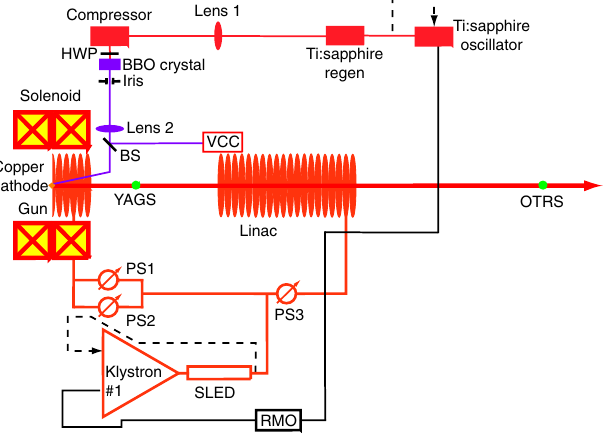
FIG. 1. Experiment schematic of the two-photon emission from a copper cathode of an X -band photoinjector (not to the scale). Lens 1 is the imaging relaying lens, lens 2 images an iris onto the cathode. HWP, half-wave plate; BS, beam splitter; VCC, virtual charge-coupled device camera; PS, phase shifter; RMO, radio master clock; YAGS, yttrium aluminum garnet screen; OTRS, optical transition radiation screen; PS, phase shifter; SLED, SLAC linac energy doubler. The solenoid has the bucking coil that makes sure the magnetic field on the cathode is zero. Klystron #1 supplies energy to SLED, which doubles the energy and lowers the repetition rate of the klystron output pulses. PS1 and PS2 adjust the amplitudes and phases of SLED output rf pulses to the gun, PS3 adjusts the phase of SLED output rf phases to the linac. YAGS collects charge on it, and is used to phase the 5.5 cell X -band rf gun. RMO provides the master radio clock to the laser oscillator and the klystron, which are both synchronized to the timing of the